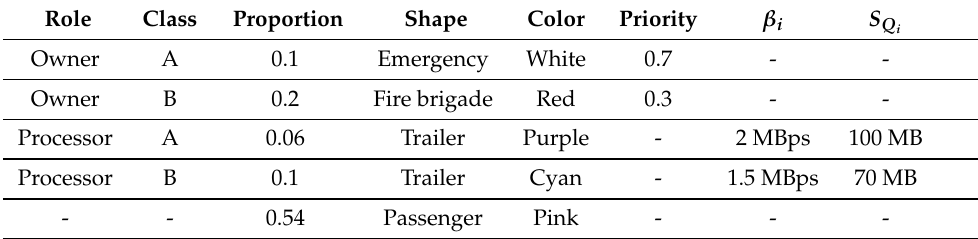
Table 5. Vehicle